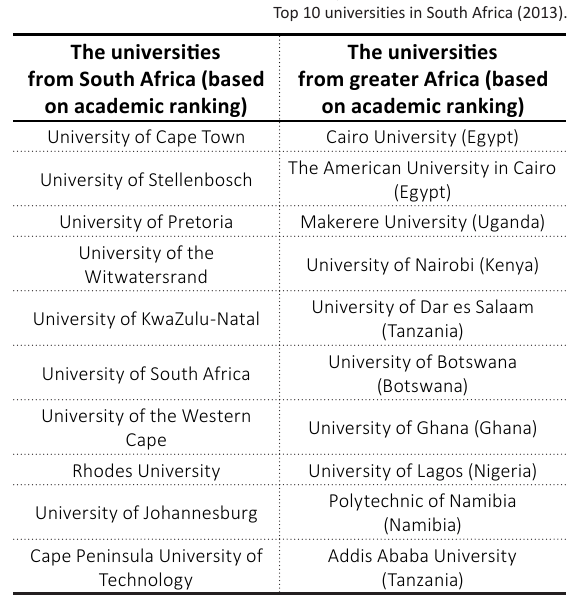
Table 1. List of universities in South Africa and greater Africa chosen for the